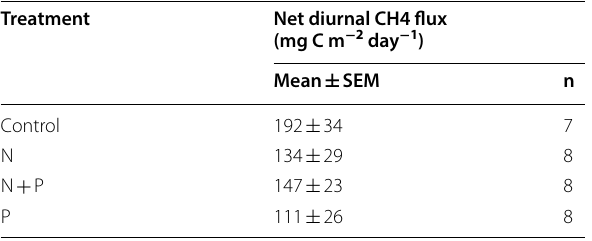
Table 6 Net diurnal CH on a 16 h–8 h light–dark cycle